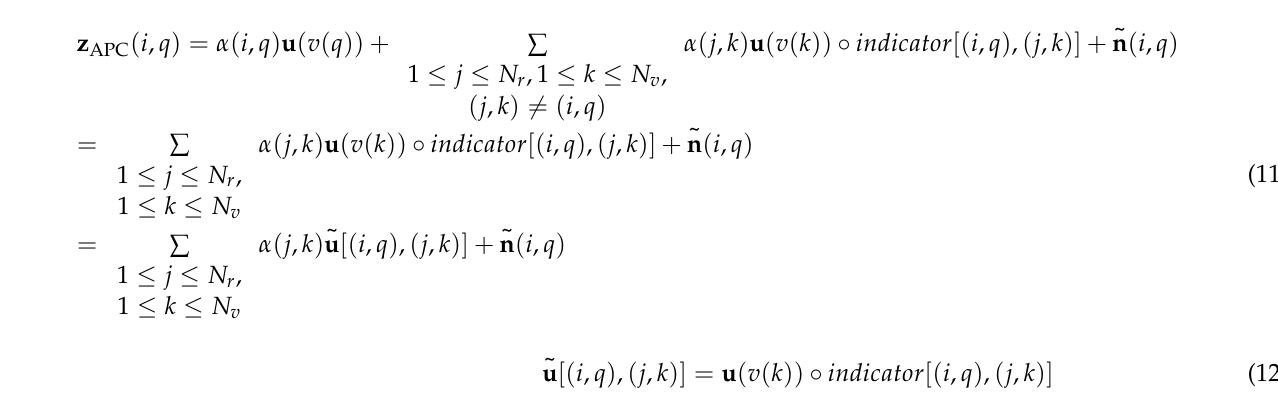
Equation (11) has a similar expression to Equation (10), so it conforms to the signal model of IAA. is the real scattering coefficient corresponding to the range-veloc- ity grid ( j , k ), especially is the real scattering coefficient of the range-velocity grid ( i , q ).